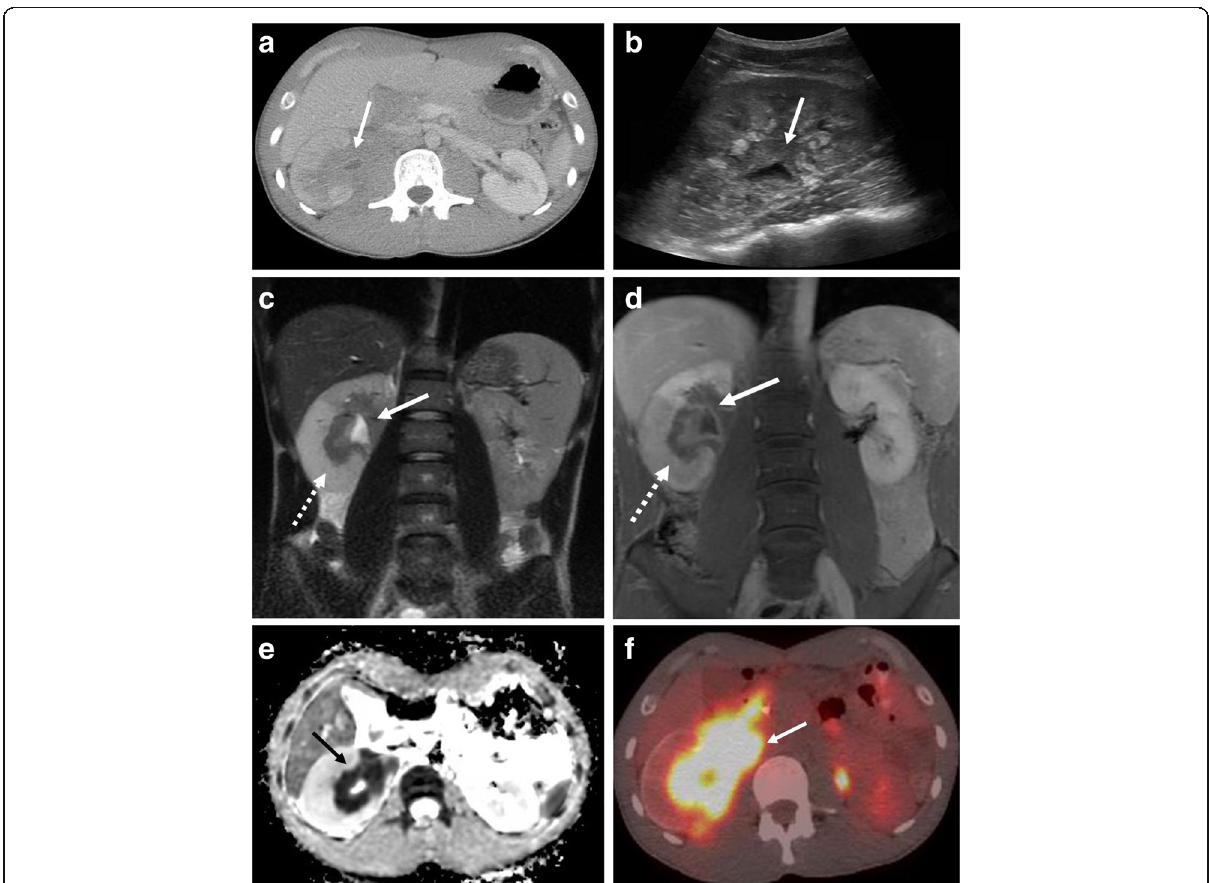
Fig. 6 Renal collecting system involvement. A 24-year-old male presenting with abdominal and lower back pain. a Contrast-enhanced axial CT image demonstrates an infiltrative soft tissue mass (arrow) encasing the right renal collecting system with resultant dilated renal pelvis and urothelial thickening. b Corresponding sagittal grayscale ultrasound image ( b ) demonstrates obliteration of the normal renal sinus fat by hypoechoic tissue encasing the renal pelvis (arrow). Follow-up MRI with ( c ) coronal T2-weighted, ( d ) coronal T1-weighted post contrast, and ( e ) axial apparent diffusion coefficient images shows a right renal pelvis mass with associated diffusion restriction (solid arrows) with edema and delayed enhancement of portions of the right renal parenchyma (dashed arrows). f Follow-up fused axial